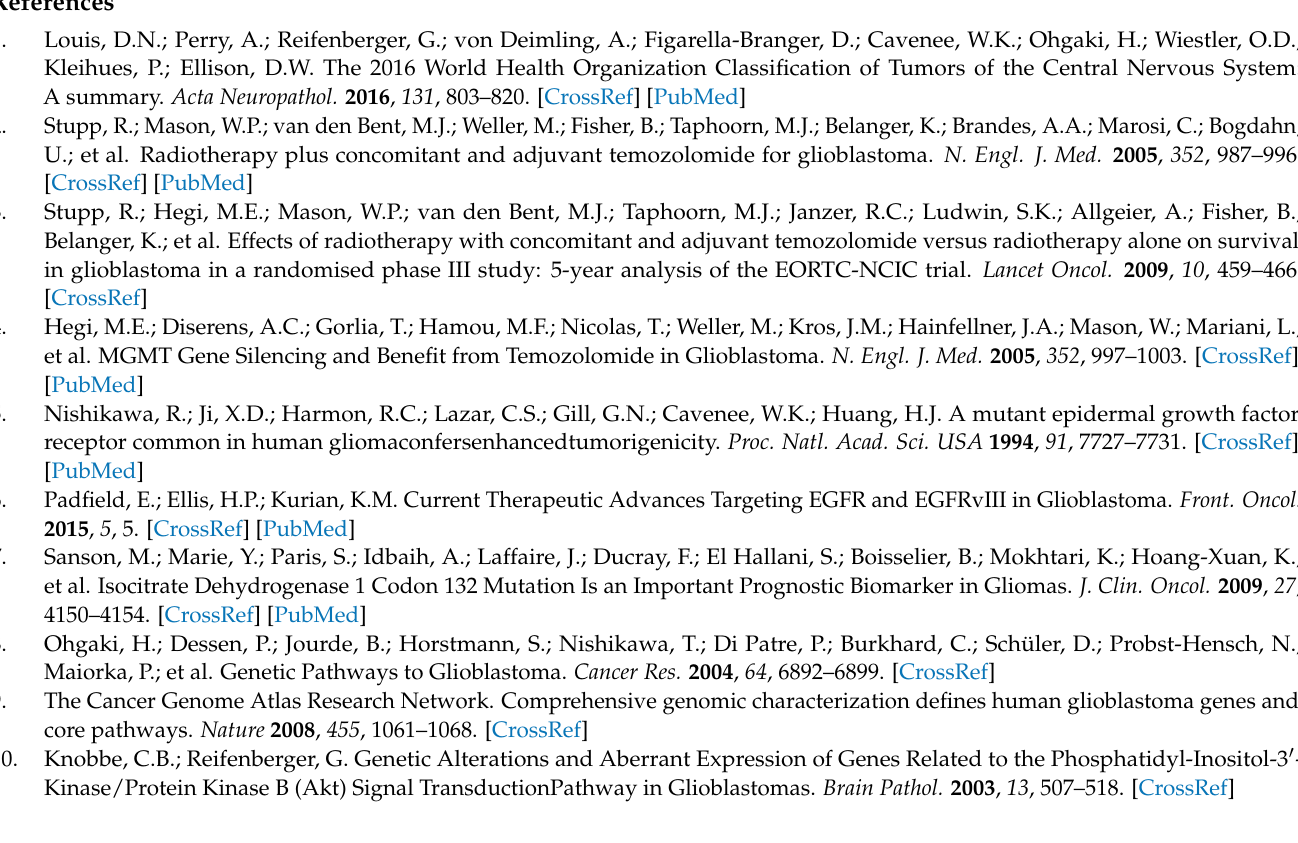
Figure S3: Dose response of temozolomide on cell proliferation in glioblastoma cell lines, Figure S4: Analysis of MGMT mRNA expression, Figure S5: Measurement of mice weights during the treatment period with clindamycin and temozolomide, Figure S6: Original Western